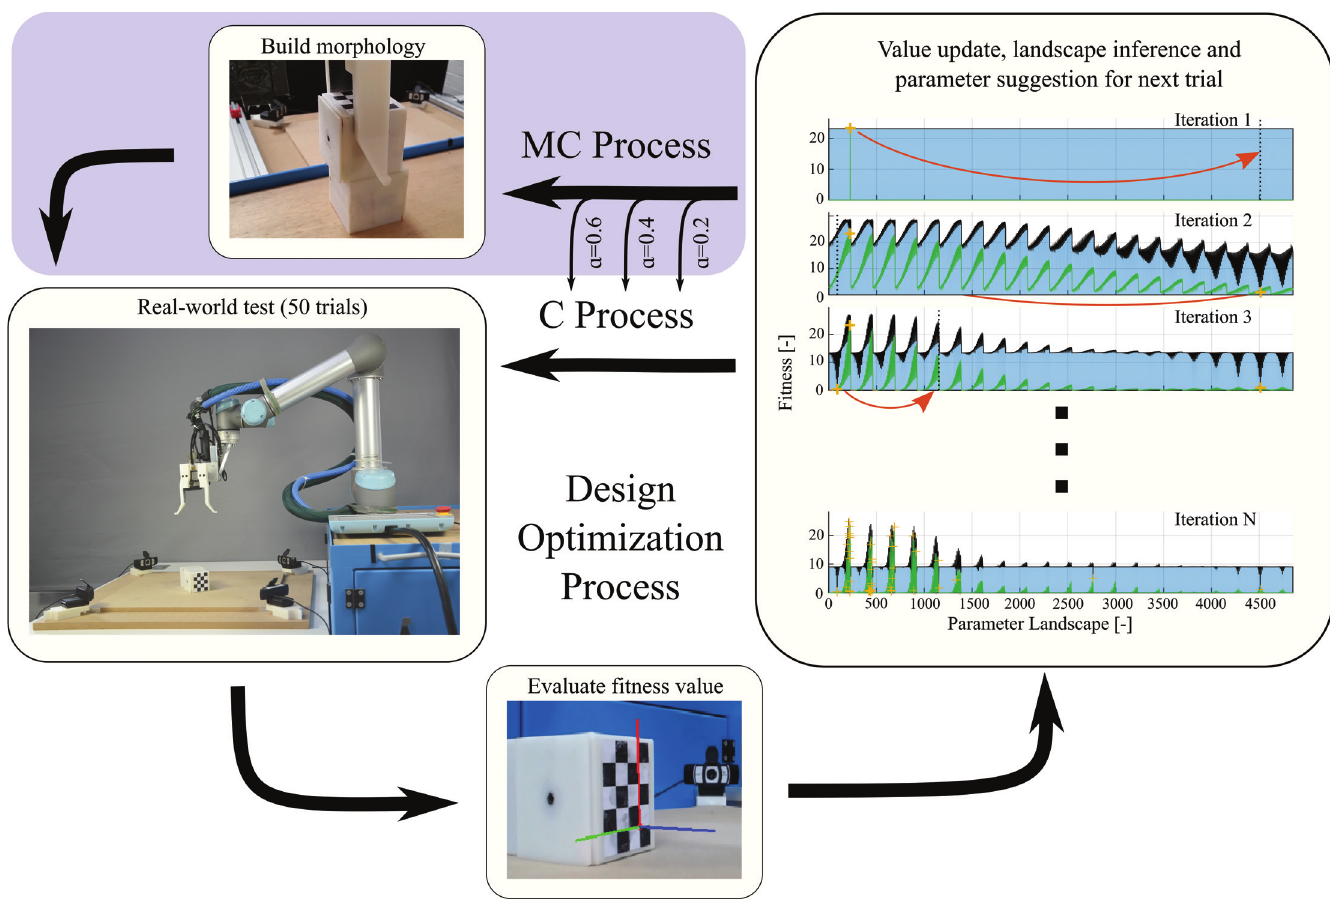
Fig 1. Overall systemconfiguration. Mother Robot uses a gripperto rotate/move boxes, and glues them together. Within the test area the robot is systematically placed in the origin position,where control signalsare applied.The outcome of each trial is recordedand evaluated, and the fitness value is used as an input to the BO, which infers the contribution from individual parameters to the fitness and suggests the next morphologyto be built. In tradit- ional engineering designs,tools such as CAE and physicalsimulatorsare used to approximate real-worldbehavior. Here, the designis autonomous and basedon real-worlddata, without model